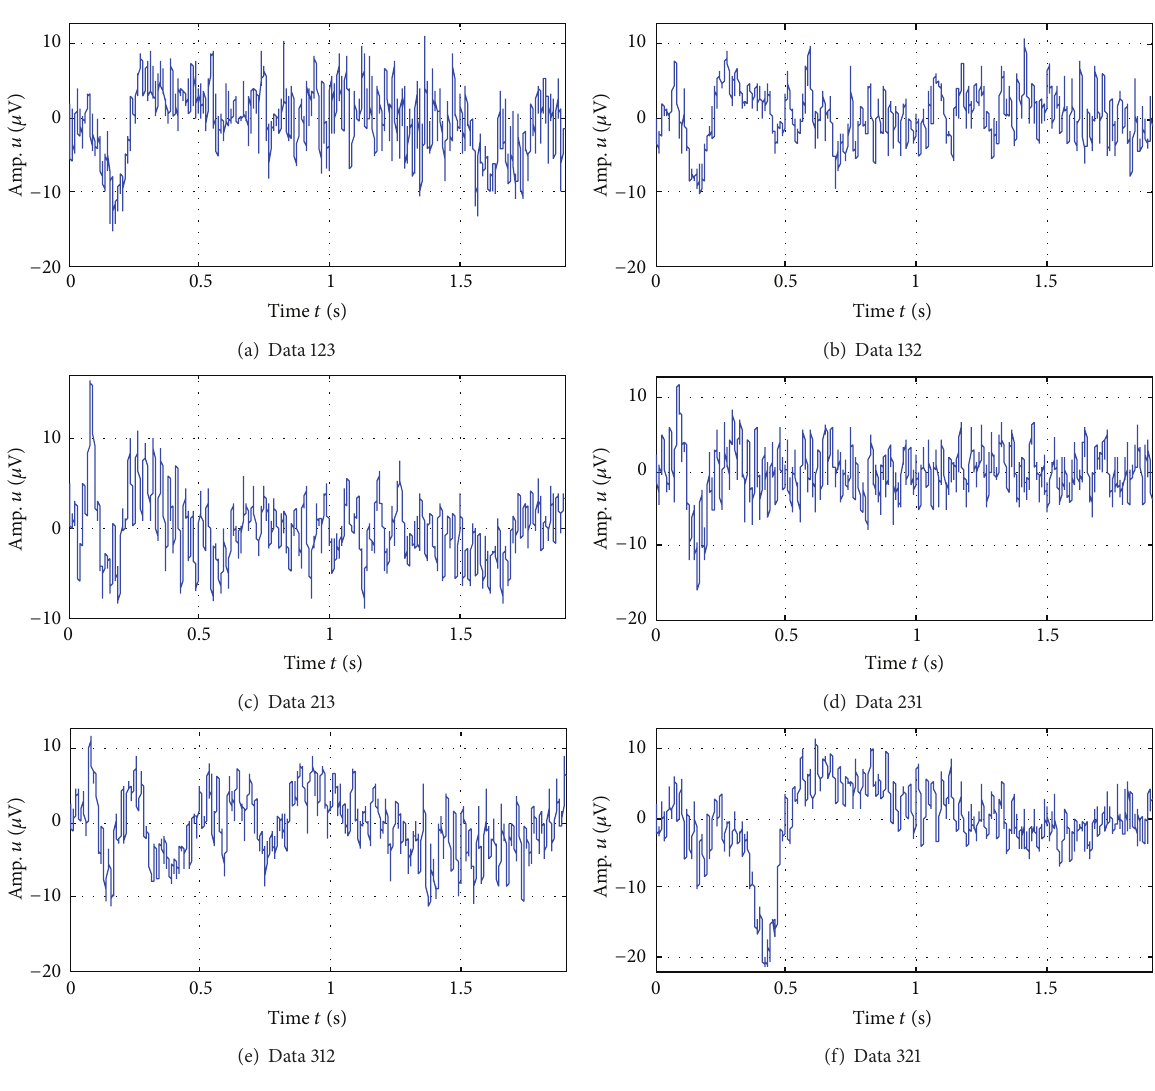
Figure 10: TSCCBH-SSVEP EEG